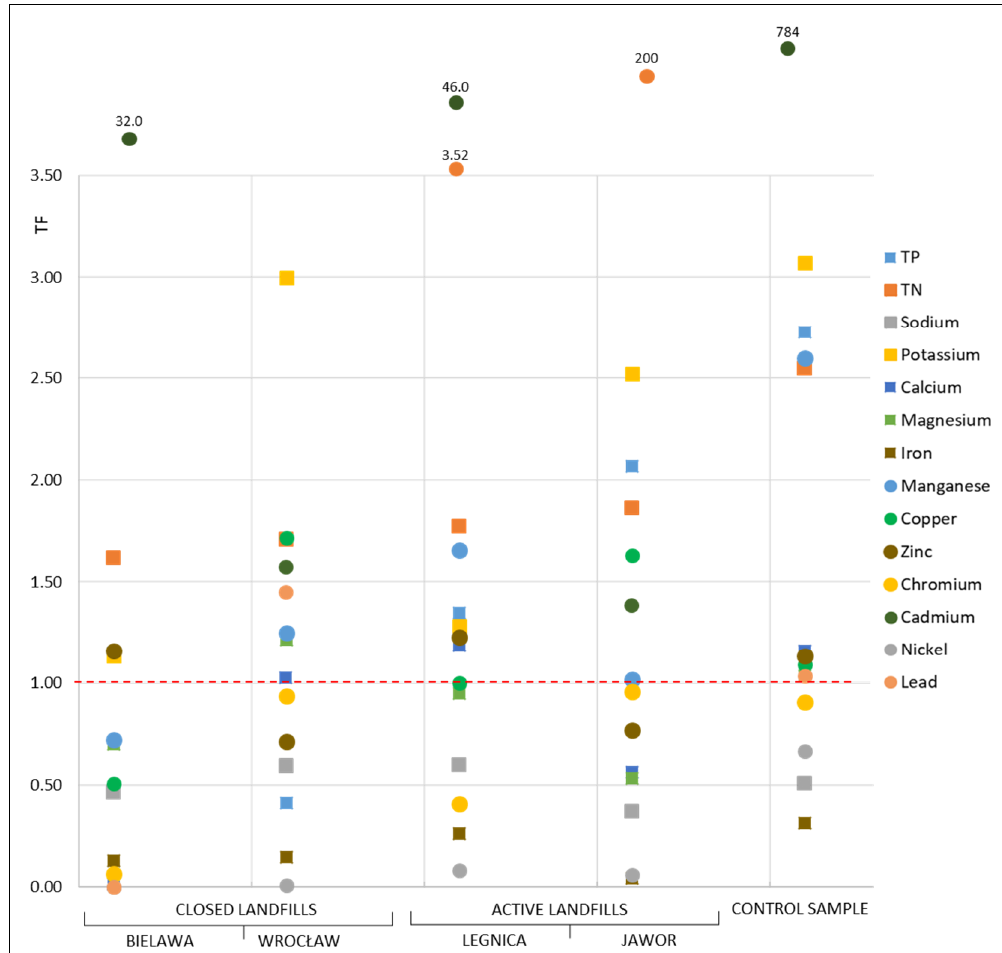
Figure 6. Translocation factor (TF) of pollutants of Phragmites australis in leachate from four municipal waste landfills.